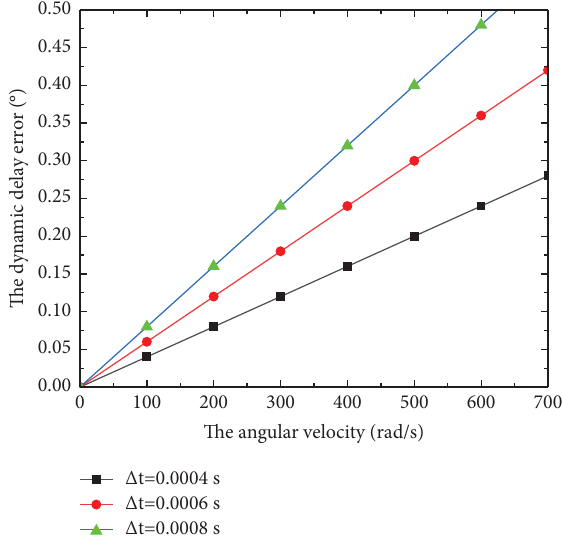
Figure 3: Te relationship between the dynamic delay error and the rotational angular velocity.